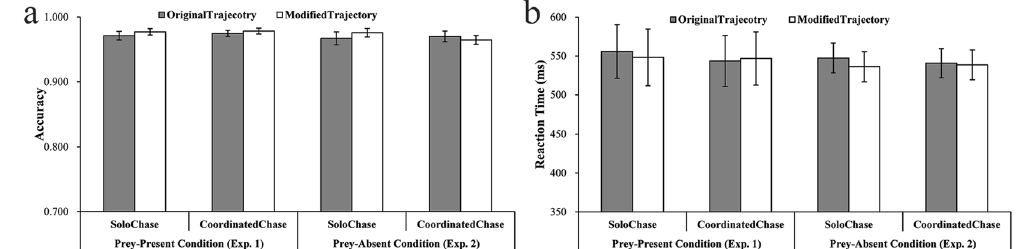
Figure 2. Behavioral results of judging the color of the flashed disc. ( a ) and ( b ) Show accuracies and reaction times (RTs) of each condition, respectively. Error bars indicate standard errors ( ± SE).